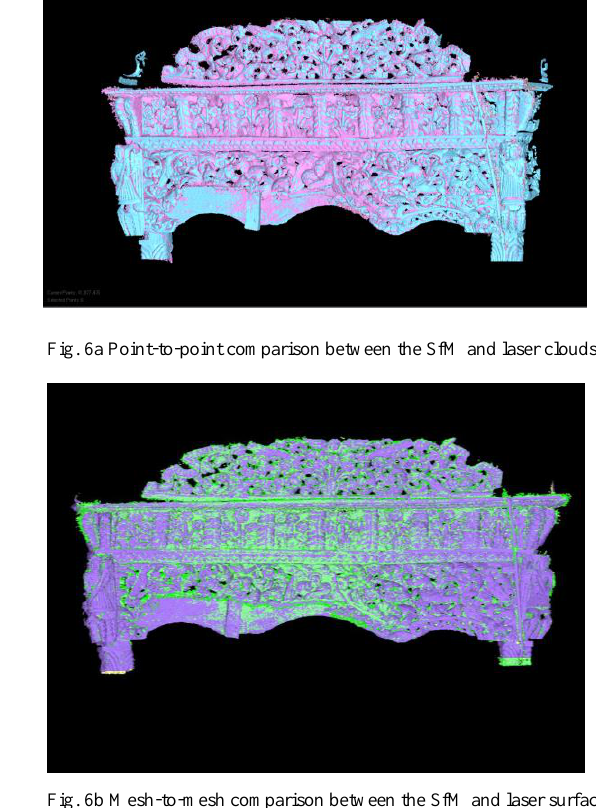
Fig. 5a Orthoimage derived using the DSM from the SfM